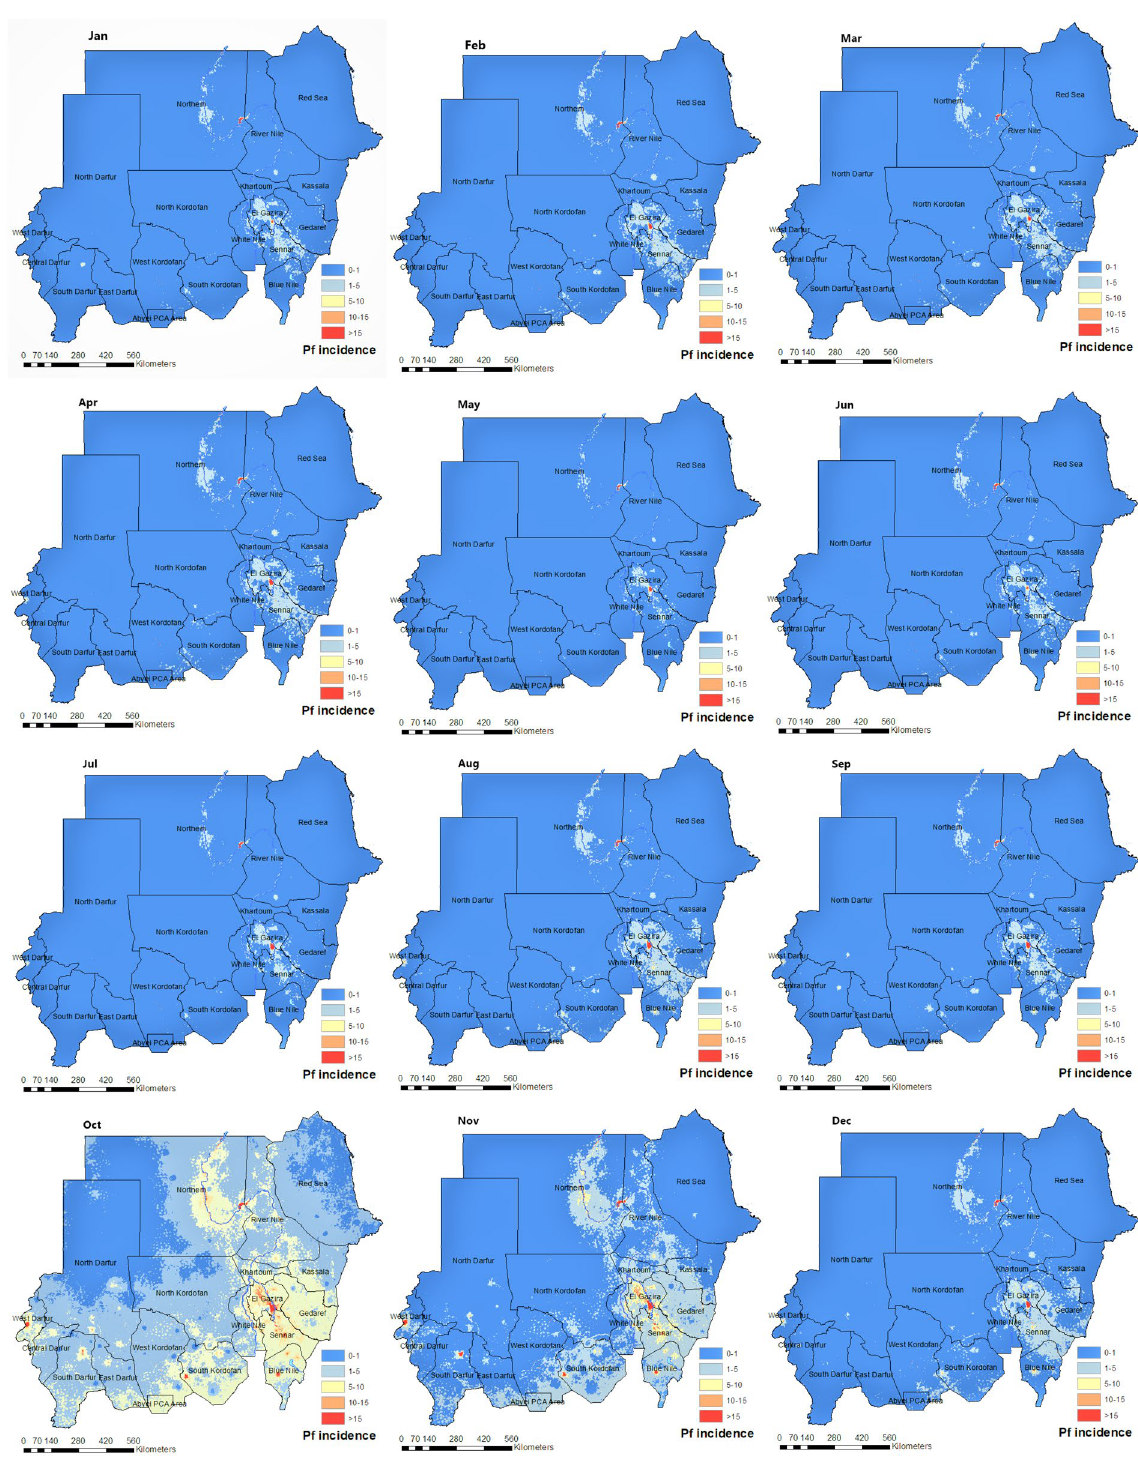
Figure 4. A fine-scale map ( 1 × 1 km) of the incidence cases of the P. falciparum malaria per 1000 in each calendar month in Sudan inferred based on our spatiotemporal Bayesian model fit to the monthly routine surveillance data between 2017 and 2019. These maps were created in ArcGIS (https:// www. arcgis. com) using the ArcMap